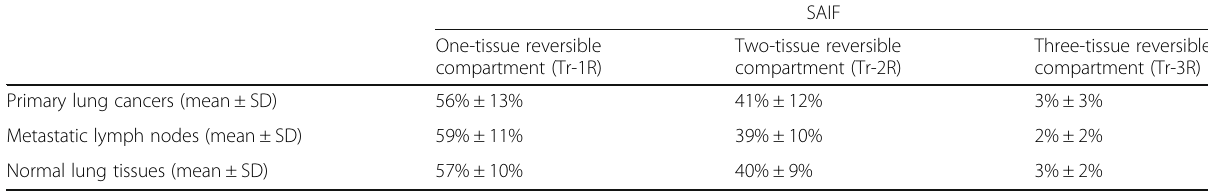
SAIF One-tissue reversible Two-tissue reversible Three-tissue reversible compartment (Tr-1R) compartment (Tr-2R) compartment (Tr-3R)